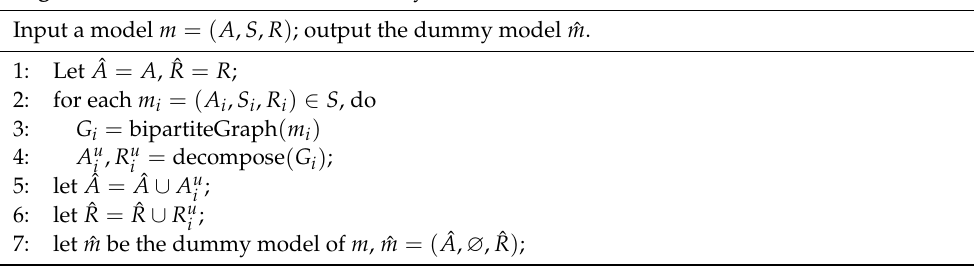
Algorithm 2. Construction of the dummy model ˆ m